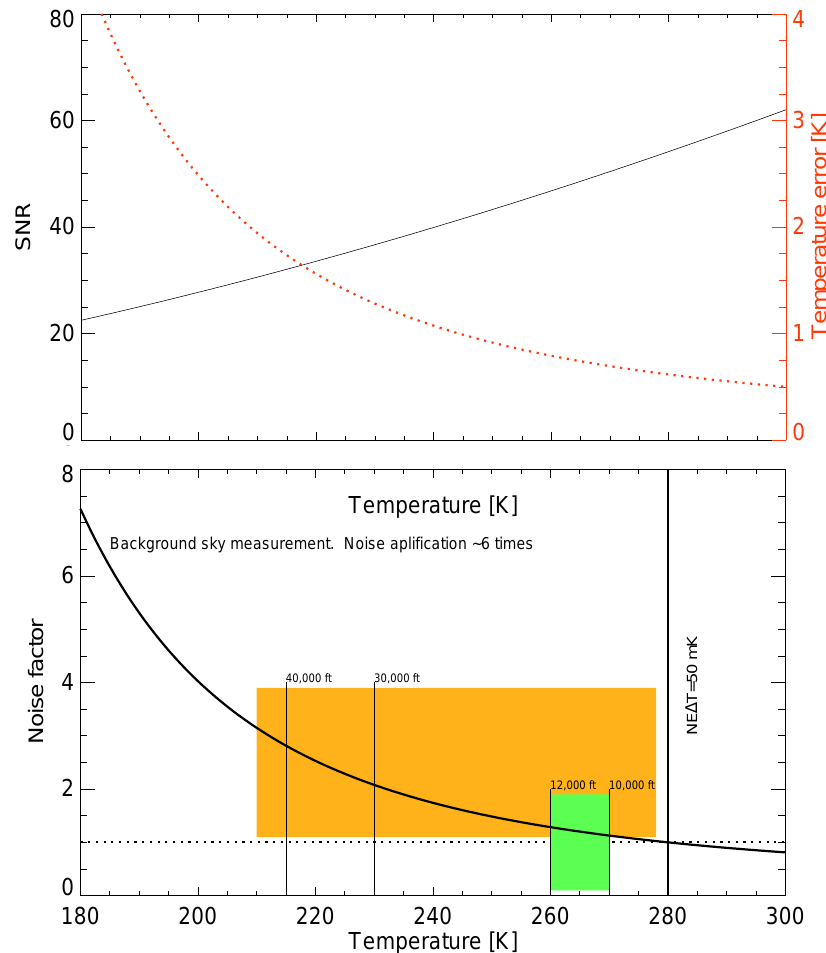
Figure 15. Noise characteristics for an uncooled bolometer measuring atmospheric radiation at various altitudes in the atmosphere. The top-panel shows the noise amplification (SNR ) and NE ∆ T (temperature error) as a function of scene temperature.